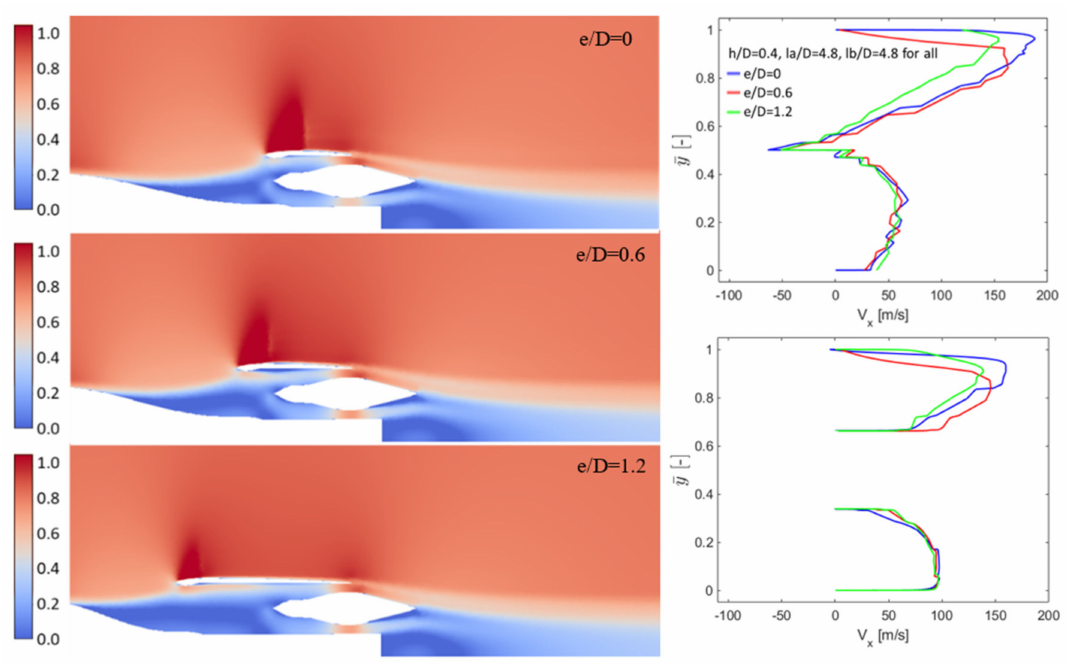
Figure 11. Contours of Mach number. Results for varying outer nacelle extensions e , 2D